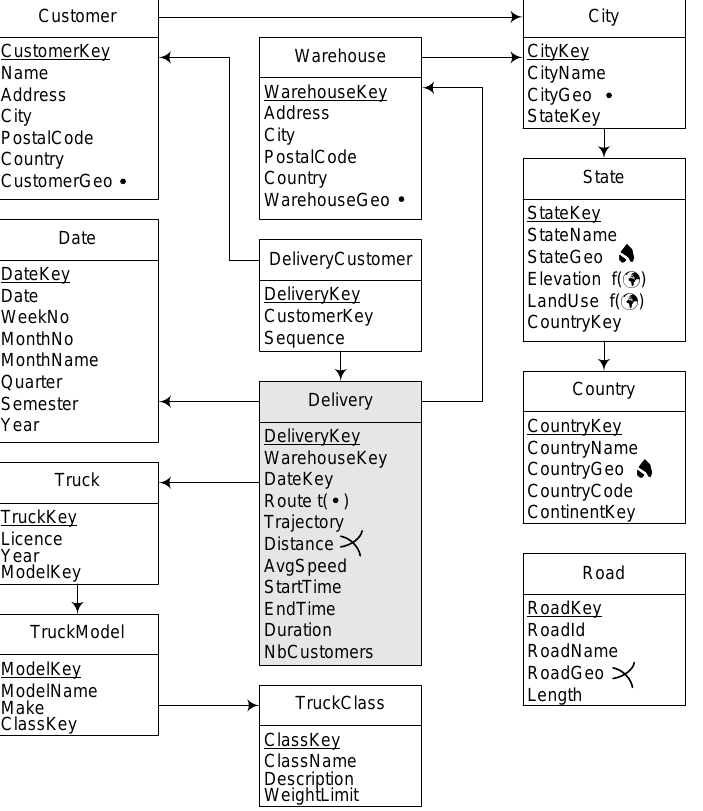
Figure 7. Logical schema of the Northwind mobility data